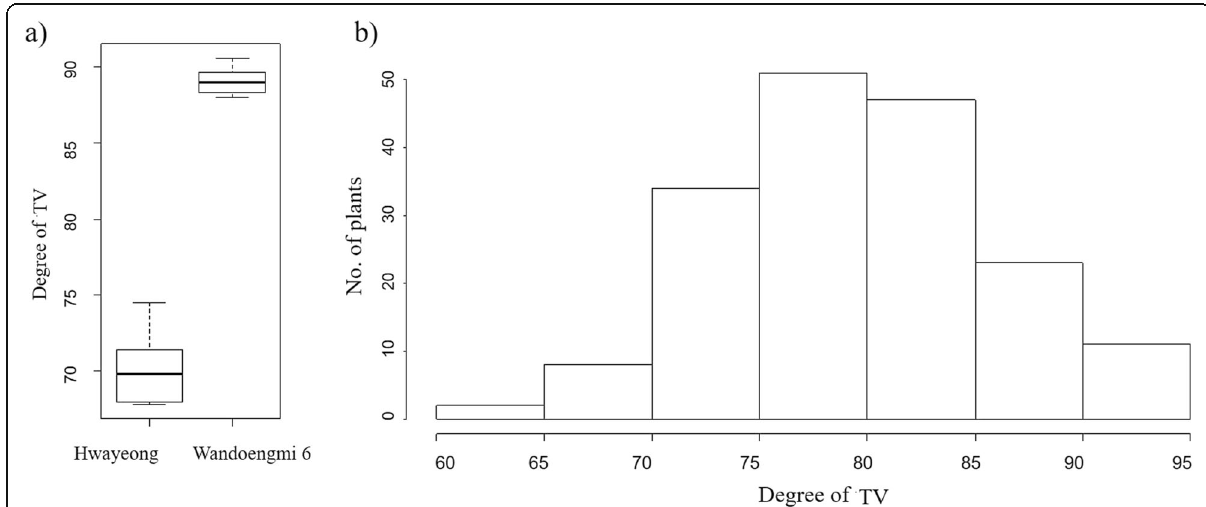
Fig. 1 Frequency distribution of 174 RILs derived from Hwayeong and Wandoaengmi6 with parents for the degree of taste value evaluated by a Toyo meter. a is a boxplot of parents for the taste value evaluated by Toyo meter (TV), and b is a histogram of the population for the taste